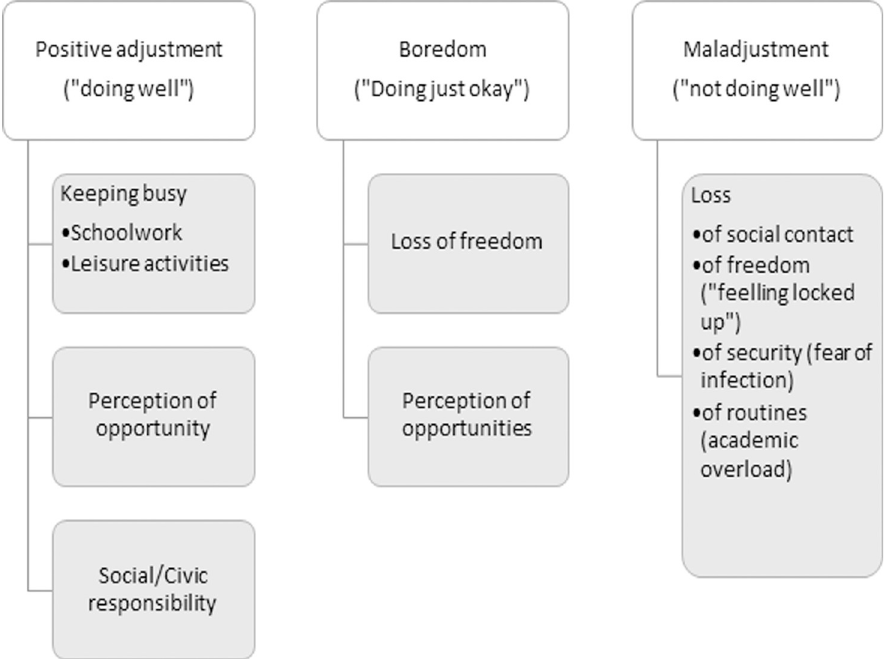
Fig 2. Core themes of adolescents’ discourse according to their perceived adaptation to